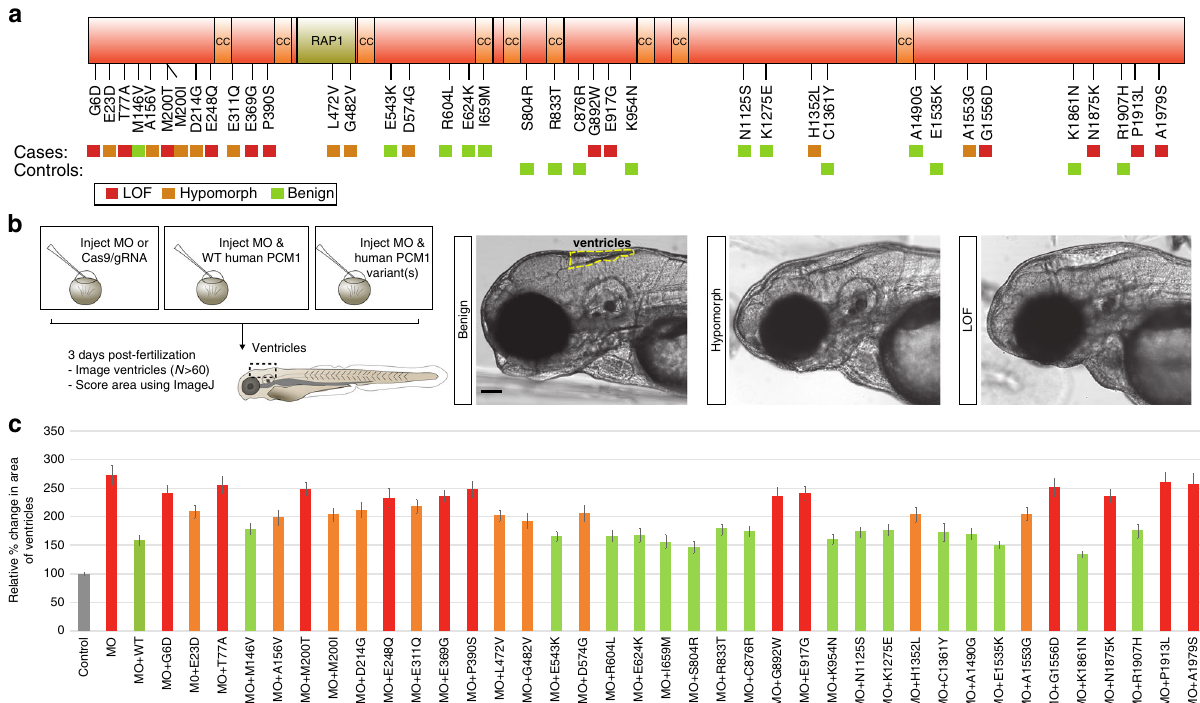
Fig. 5 Enrichment of rare, pathogenic PCM1 mutations in ASZ and functional modeling. a Schematic depicting PCM1 protein and the location of protein interaction domains, and ultra-rare non-synonymous changes identi fi ed in both severe SZ cases and controls from the discovery and replication cohort. Colored boxes indicate loss of function (LOF), hypomorphic, or benign results from functional modeling in the zebra fi sh. b Schematic showing the functional modeling procedure in zebra fi sh embryos. 3 dpf, embryos imaged and ventricles quanti fi ed using ImageJ. Representative images for benign, hypomorphic, and LOF alleles are presented. Scale 100 µ m ( c ) Normalized values for the average ventricular area of each variant discovered from severe SZ cases and controls are plotted relative to MO and MO + WT conditions. N fi sh/variant shown in Supplementary Table 1 with p values. Data as mean ± SD. LOF loss of function, CC coiled-coils domain, RAP1 rhoptry-associated protein 1 sequence, CI con fi dence interval, MO morpholino, WT wild-type. Detailed statistics in Table 1. Source data are provided as a Source Data File. Illustrations are